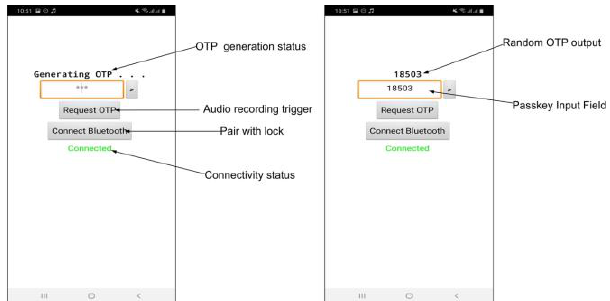
Fig. 11. The Android Application Interface showing request